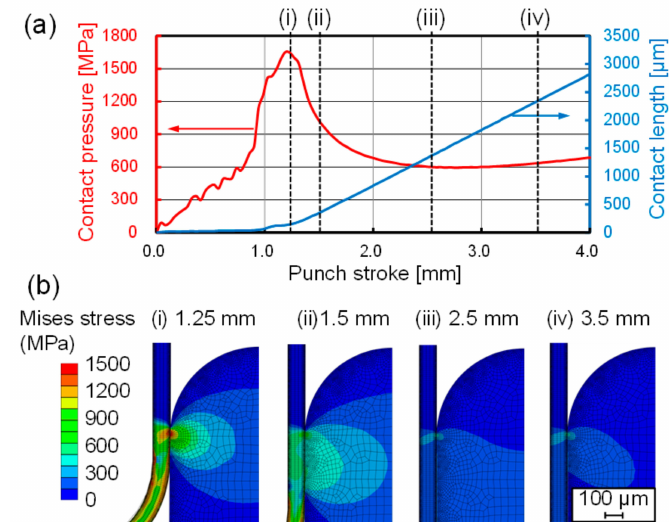
Figure 5. Results of the contact state analysis. ( a ) Variations of the contact pressure and apparent contact length during bending with the ironing process, ( b ) variation of the equivalent stress distribution at each punch stroke denoted in ( a